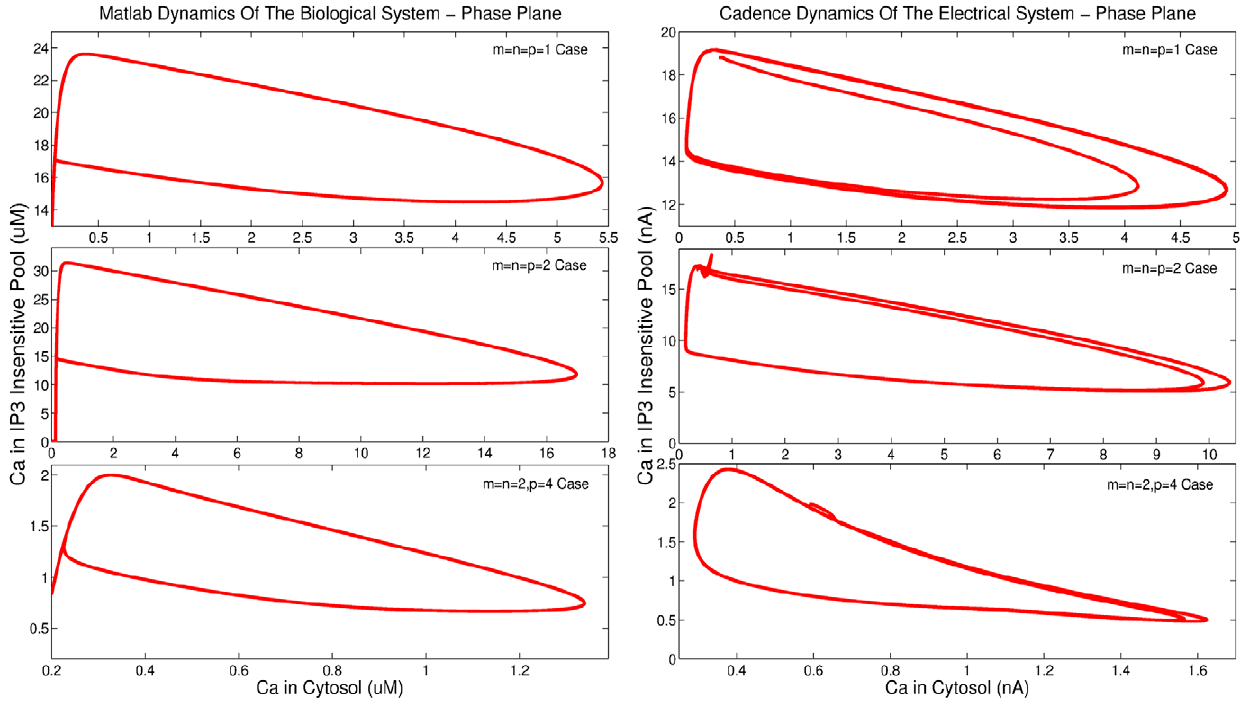
Figure 10. Comparison of phase plane analysis results generated by MATLAB (cid:2) and Cadence simulations for the Log-Domain intracellular Ca 2 + oscillations circuits.